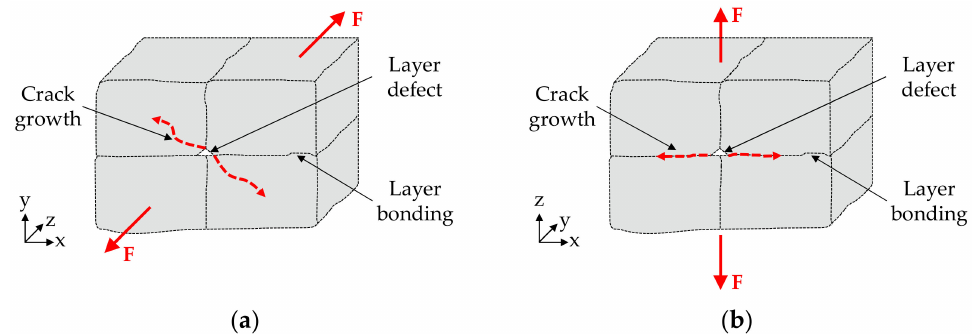
Figure 17. Schematic representation of fracture model (cf. [38]): ( a ) Flat orientation: crack growth within extrusion paths; ( b ) vertical orientation: crack growth between the layer